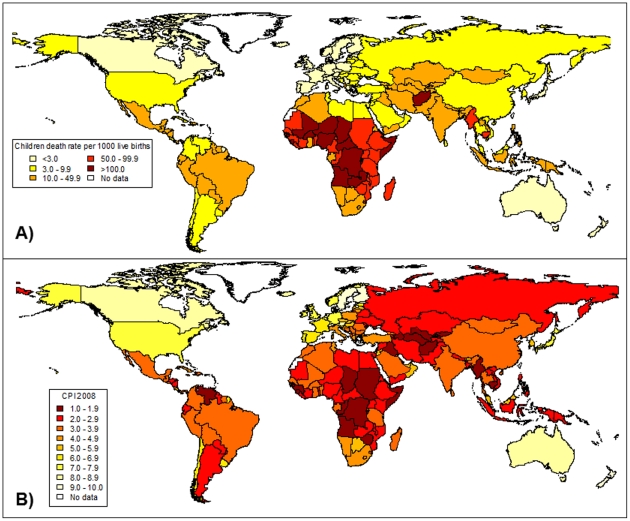
World repartition of children deaths and perceived corruption.A) Deaths of children younger than 5 years per 1000 live births in 2008. Derivated from data compiled by Black and colleagues [11]. B) Corruption Perceptions Index (CPI) in 2008. Derivated from data compiled by Transparency International [10].